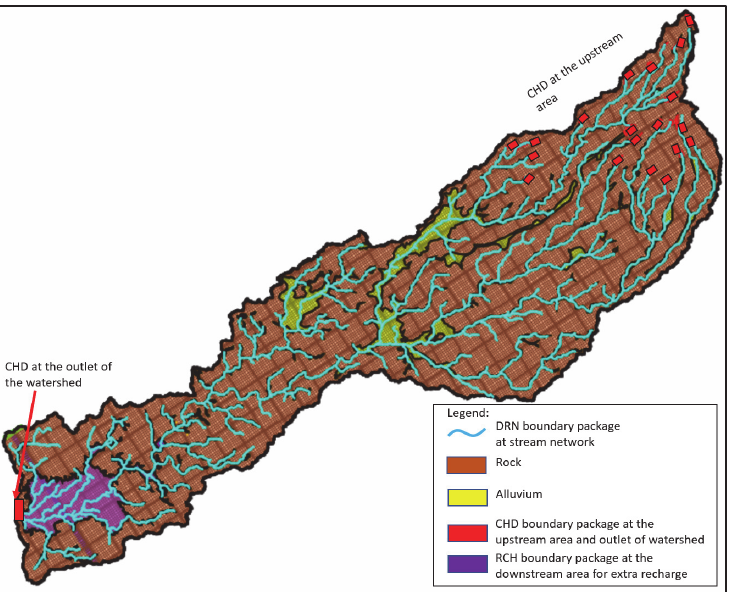
Figure 25. Transient groundwater modeling appearances on MODFLOW 6 for scenario 1, involving several boundary conditions packages (i.e., CHD, DRN, EVT, and RCH). The EVT and RCH are applied to the whole watershed, and the RCH for extra recharge is applied for the downstream of the Al ‐ Lusub watershed.